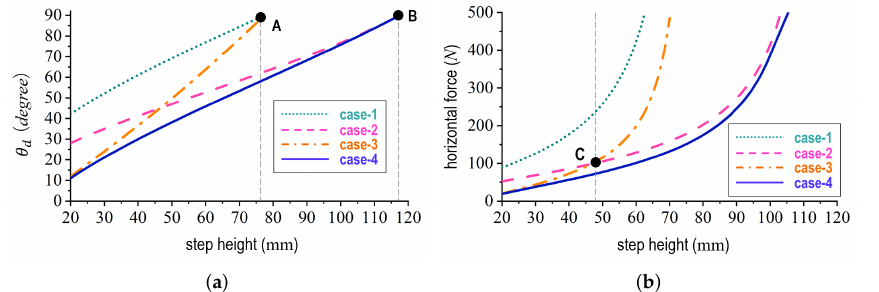
Figure 15. Analytic results for both required horizontal forces and step-height-based equivalent gradient when ascending a step (where case-1, case-2, case-3, and case-4 denote a conventional wheel, a wheel with vertically translated axle, a wheel with horizontally translated axle, and the proposed wheel, respectively.) ( a ) Required horizontal forces; ( b ) step-height-based equivalent